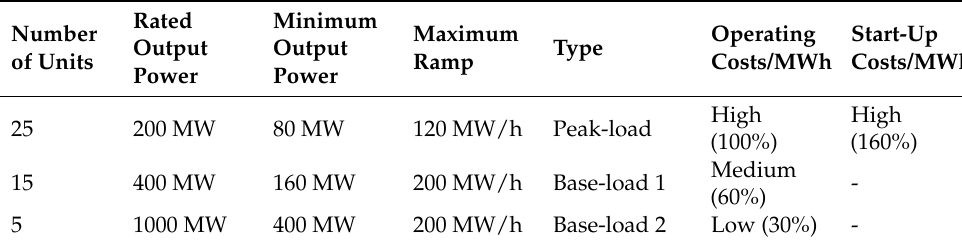
Table 1. Parameters of the model—centrally dispatch power generating units (CDGUs). Cost parameters based on